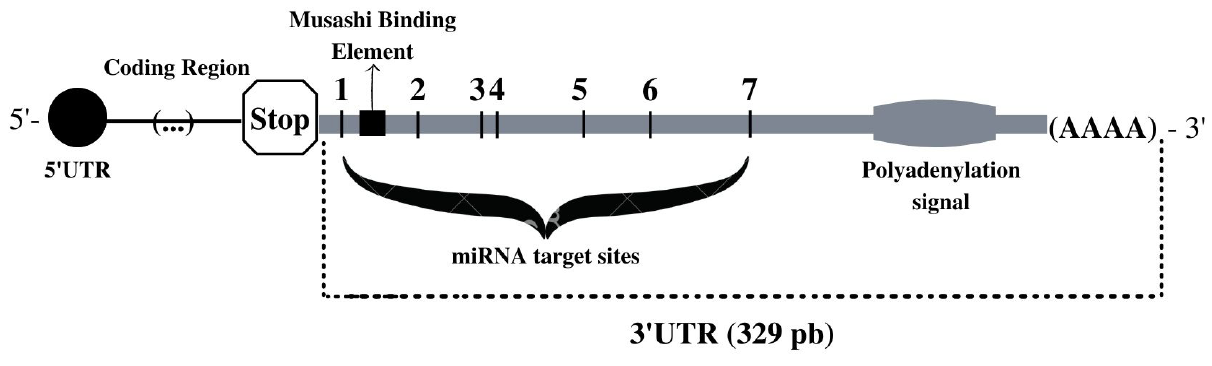
Figure 2 – Summary of the elements found associated with the 3’UTR of BTD